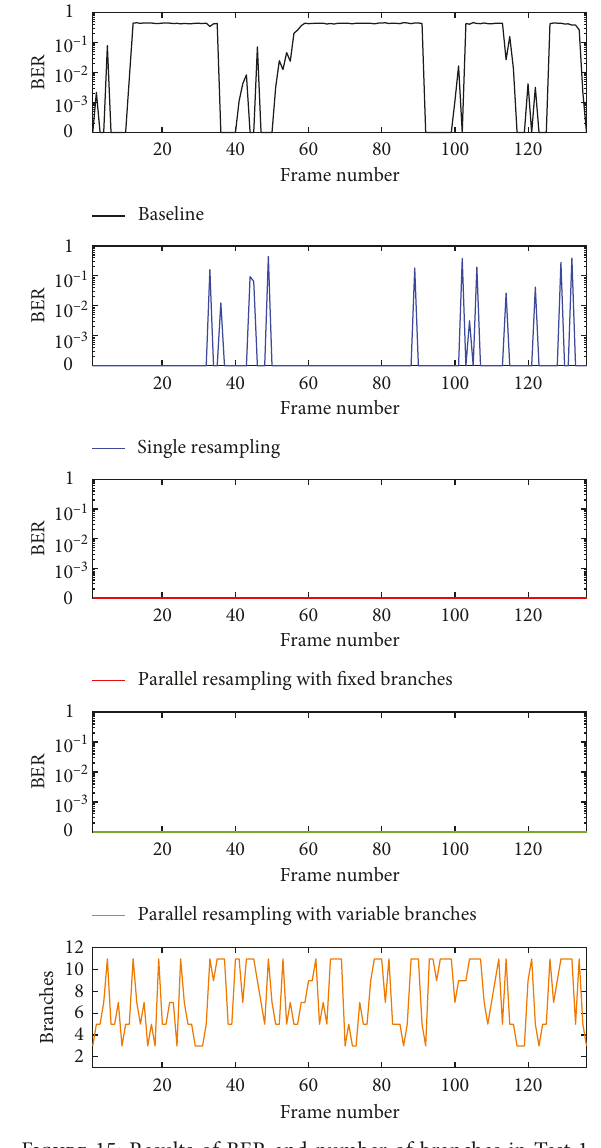
Figure 15: Results of BER and number of branches in Test